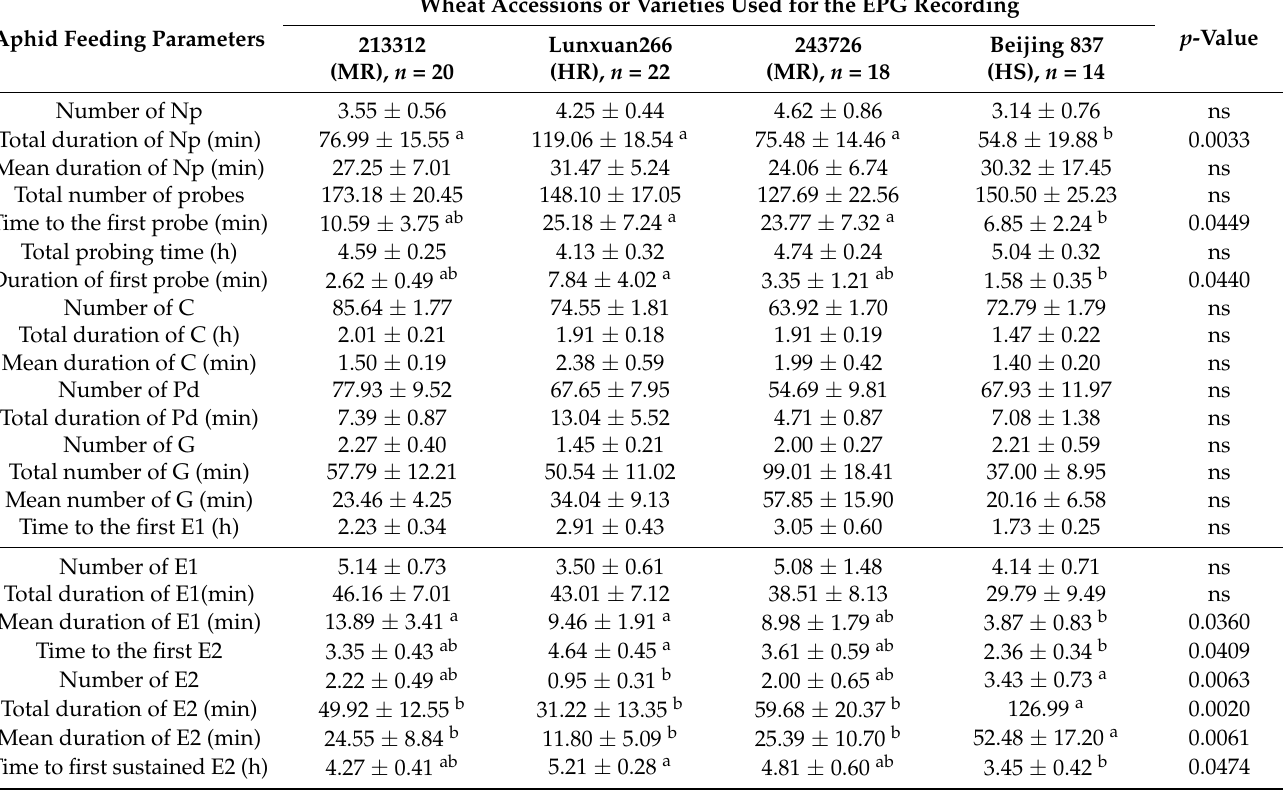
Table 3. EPG Parameters of S. miscanthi on seedlings of four different wheat